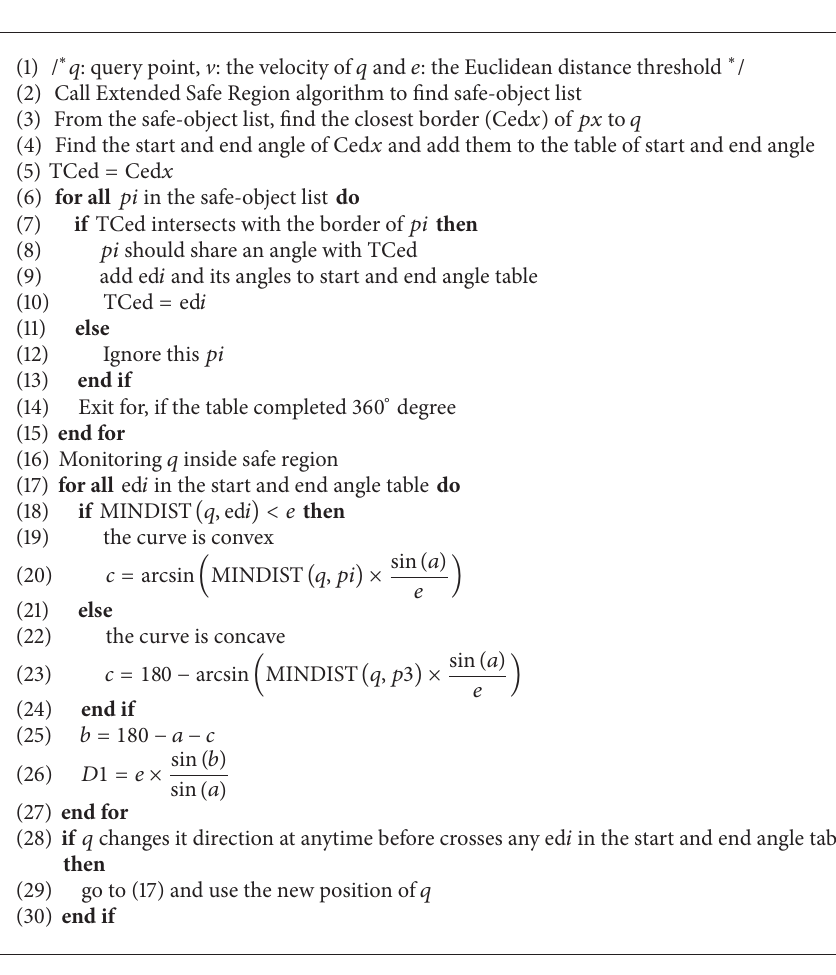
Algorithm 2: Monitoring moving range query